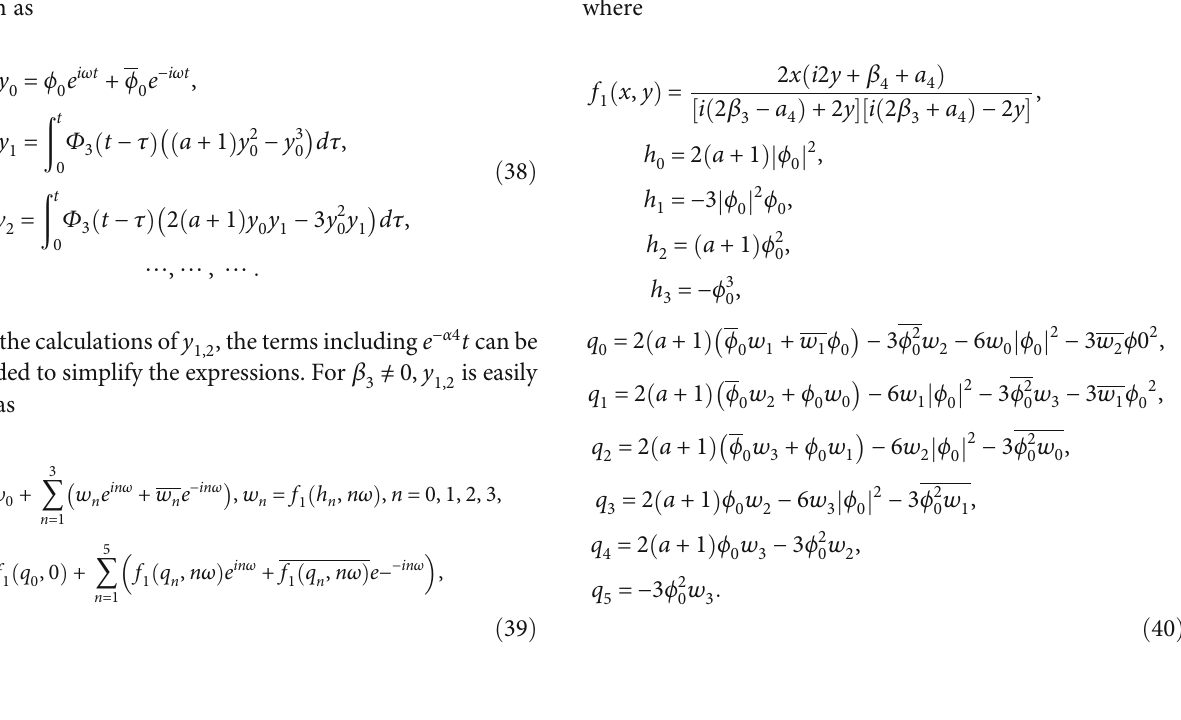
Figure 1: The dynamics of u The dynamics of u u ð 0 Þ = 0 : 02 , and u 3